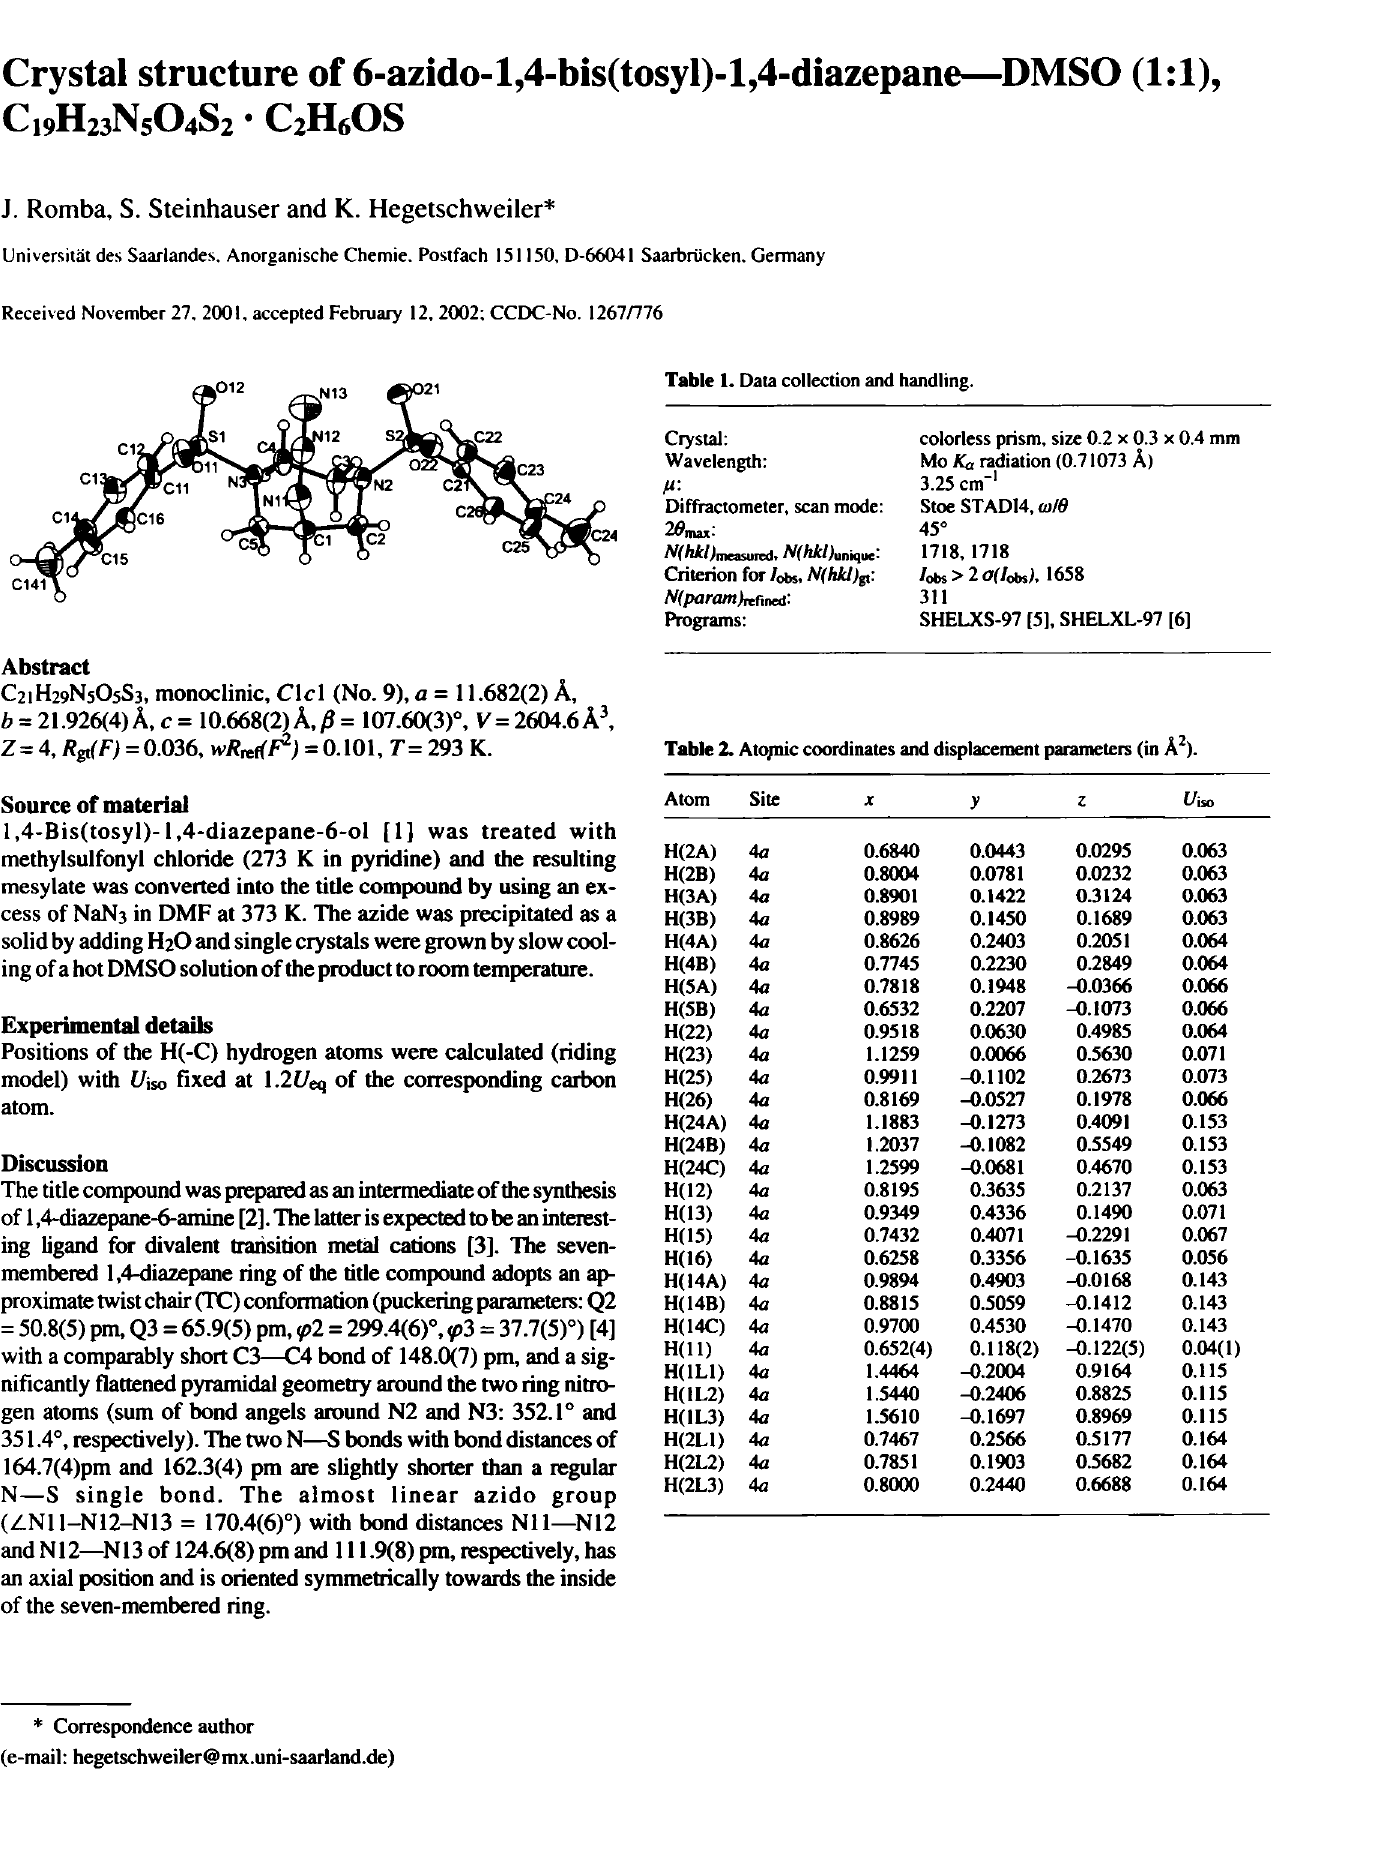
Table 2. Atopic coordinates and displacement parameters (in Â 2